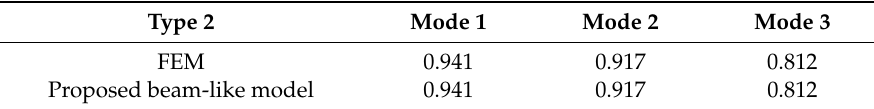
Table 3. Modal Period